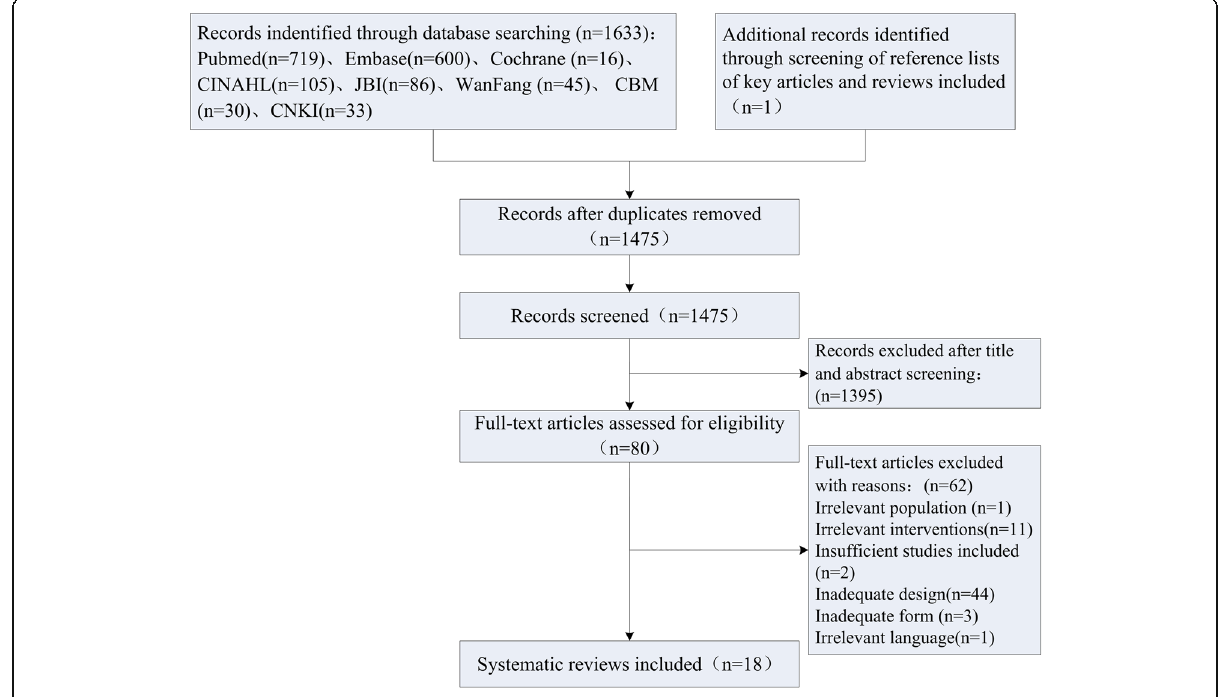
Fig. 1 Flowchart of the systematic review selection